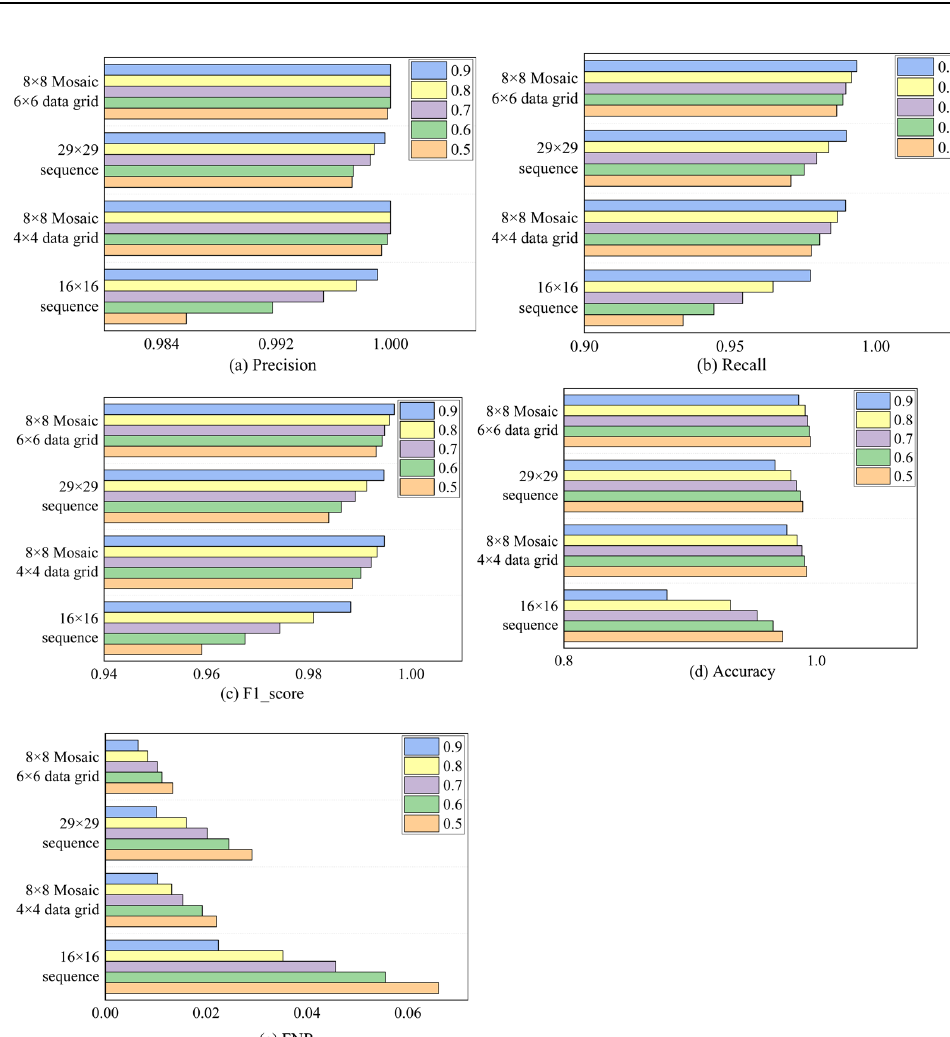
Figure 9. The change of performance for each model, under different thresholds for Fuzzy dataset.